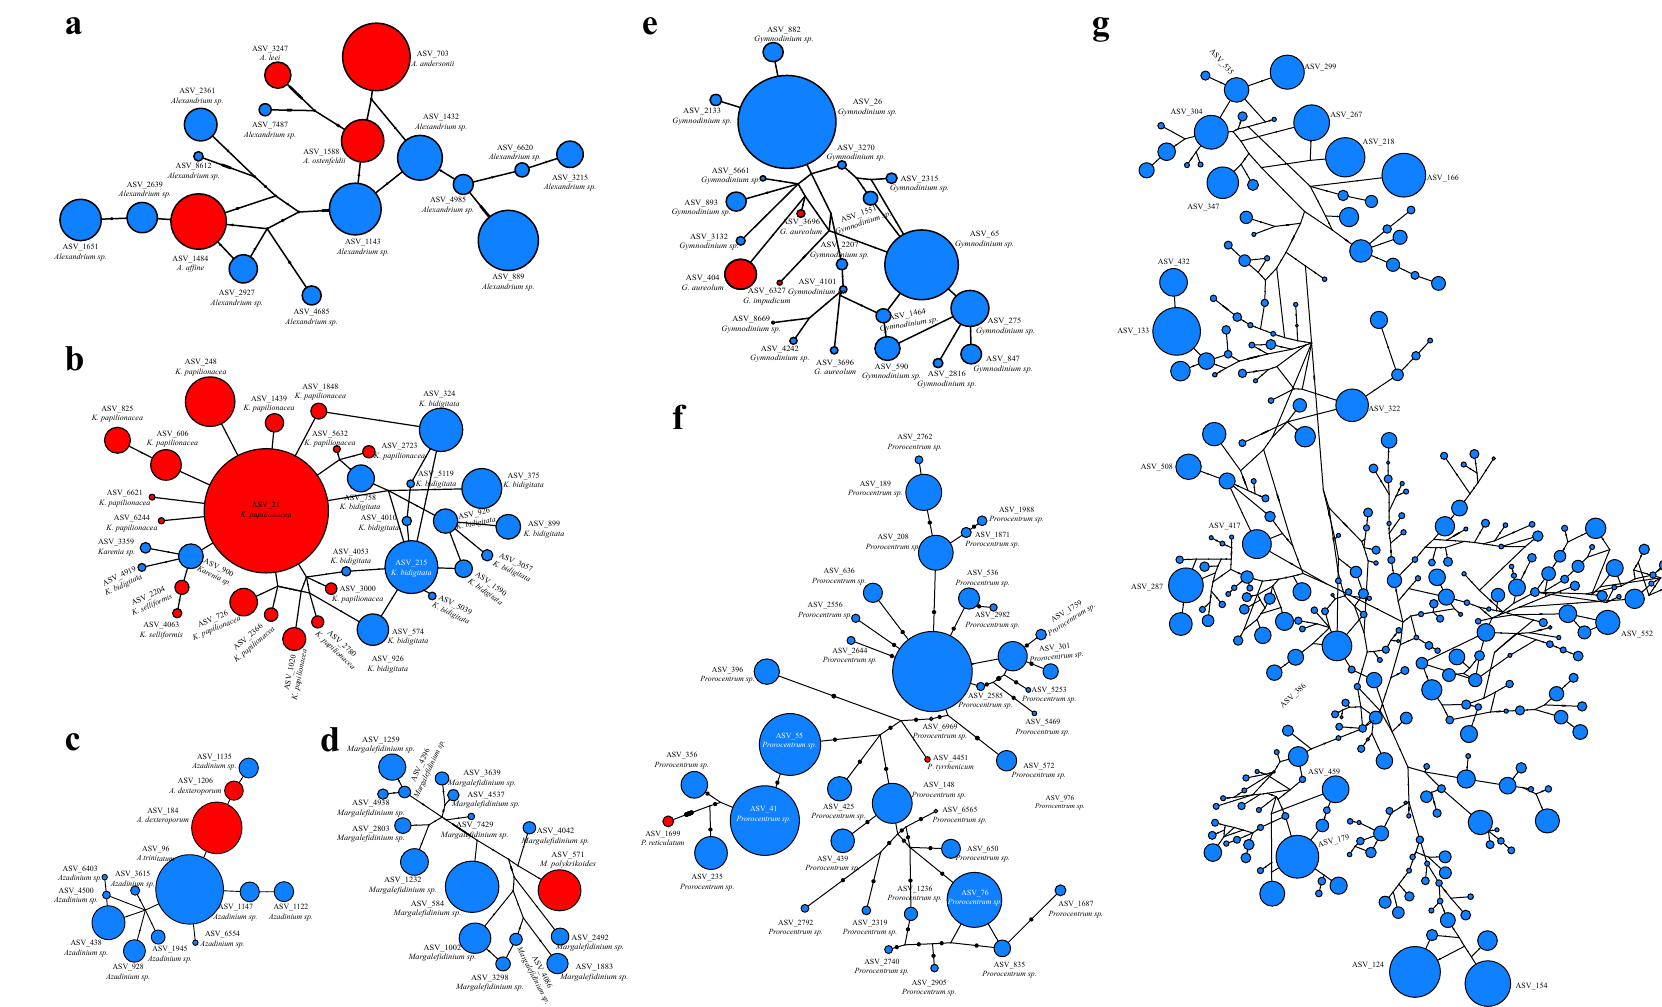
Figure 7. Phylogenetic network analysis of representative genera identified in the Western Pacific seamount regions. ( a ) Alexandrium ; ( b ) Karenia ; ( c ) Azadinium ; ( d ) Margalefidinium ; ( e ) Gymnodinium ; ( f ) Prorocentrum ; ( g ) Dino − Group − I − Clade − 5_X . The size of the circles represents relative abundance of each ASV, while red color represents HAB